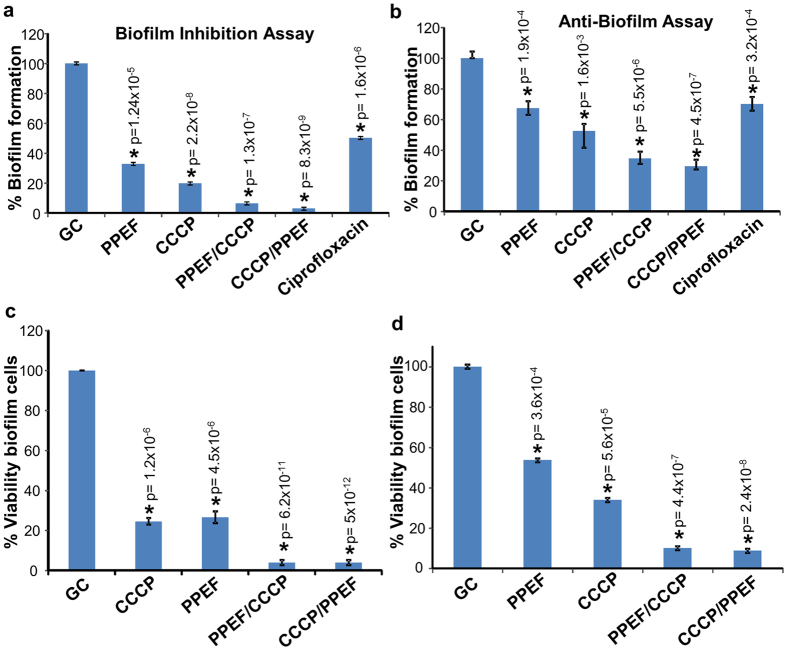
PPEF and CCCP in combination inhibit the biofilm mass, eradicate preformed biofilm and kills the biofilm forming cells.(a) Biofilm inhibition assay in presence (1XMIC) PPEF, (1XMIC) CCCP, in combination of (1XMIC) PPEF and (1/2XMIC) CCCP, in combination of (1XMIC) CCCP and (1/2XMIC) PPEF and 1XMIC ciprofloxacin. (b) Pre-formed biofilm eradication assay in presence of (1XMIC) PPEF, (1XMIC) CCCP, in combination of (1XMIC) PPEF and (1/2XMIC) CCCP, in combination of (1XMIC) CCCP and (1/2XMIC) PPEF and 1XMIC ciprofloxacin. (c) The percentage of viable cells forming biofilm determined by MTT with respect to control in presence (1XMIC) PPEF, (1XMIC) CCCP, in combination of (1XMIC) PPEF and (1/2XMIC) CCCP, in combination of (1XMIC) CCCP and (1/2XMIC) PPEF. (d) The percentage of viable cells treated after biofilm formation determined by MTT reduction to its insoluble formazan with respect to control samples in presence (1XMIC) PPEF, (1XMIC) CCCP, in combination of (1XMIC) PPEF and (1/2XMIC) CCCP, in combination of (1XMIC) CCCP and (1/2XMIC) PPEF. Results are presented of three independent experiments (n = 3) presented as mean ± SD. Statistical analysis was done by one way ANOVA followed by two tailed‘t’ test. Asterisks (*) indicates statistical significance and (*P ≤ 0.05) values are considered significant. Detailed statistically significant p-values of control vs. experimental are indicated.